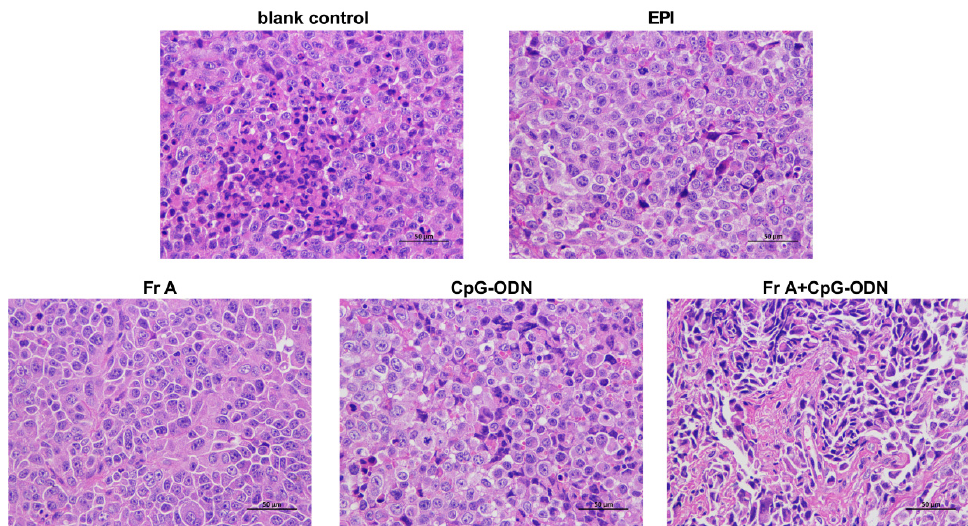
Figure 8. Histopathologic sections of tumor tissues (H&E, × 200). Nude mice were treated with different drugs in 14 days. All of the animals were sacrificed after the treatments and the tumors were collected for histological analysis.